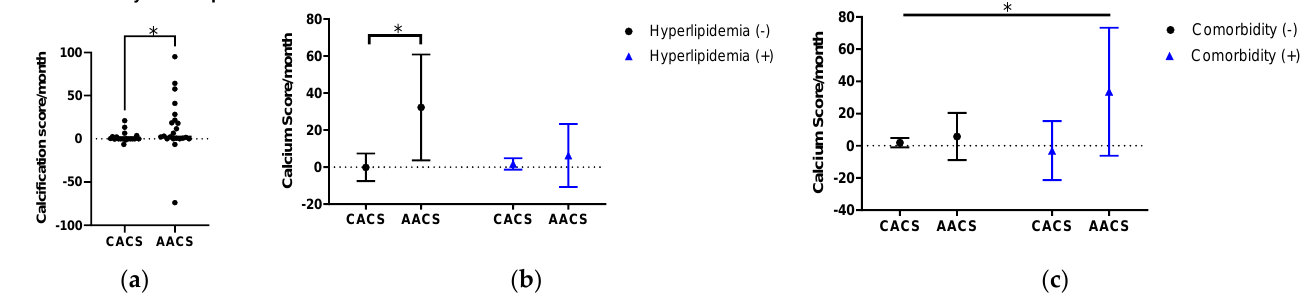
Figure 8. ( a – c ): Absolute calcification score progression during follow-up (pooled two-way ANOVA with *: p <0.05).